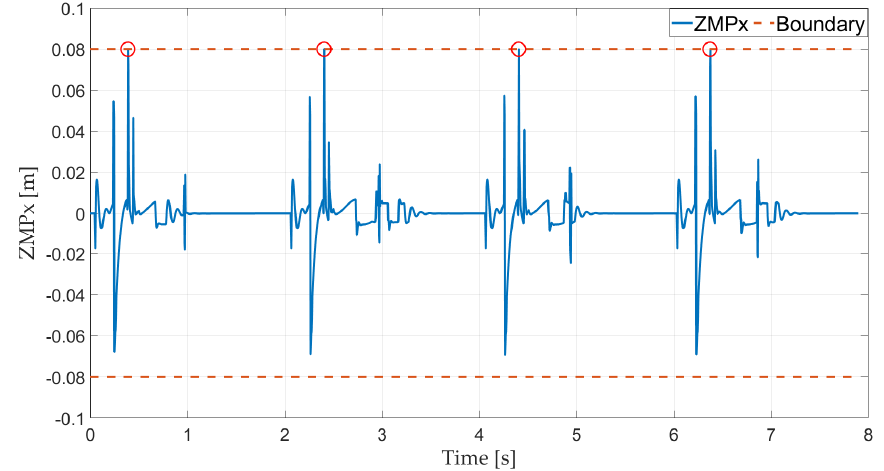
Figure 10. Foot ZMP in the x-axis.